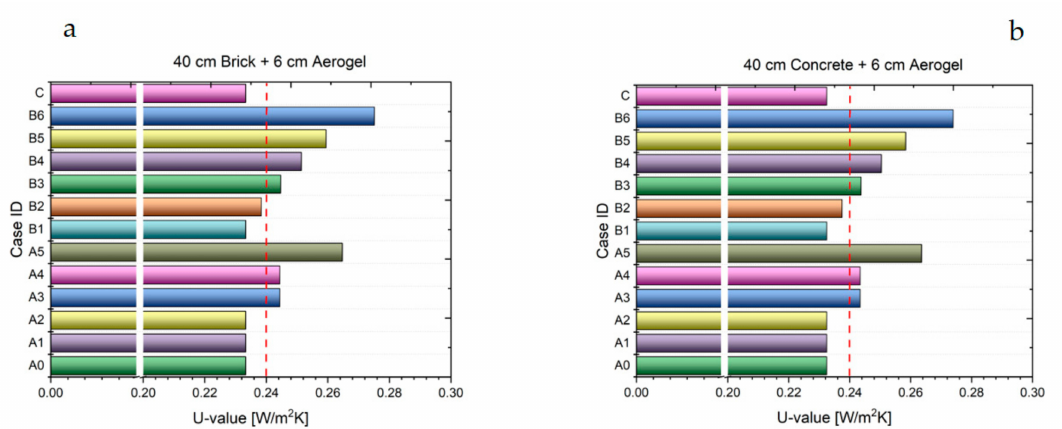
Figure 5. The structure with U = 0.24 W / m 2 K thermal transmittance. ( a ) Brick with 6 cm of aerogel and ( b ) concrete with 6 cm of aerogel.